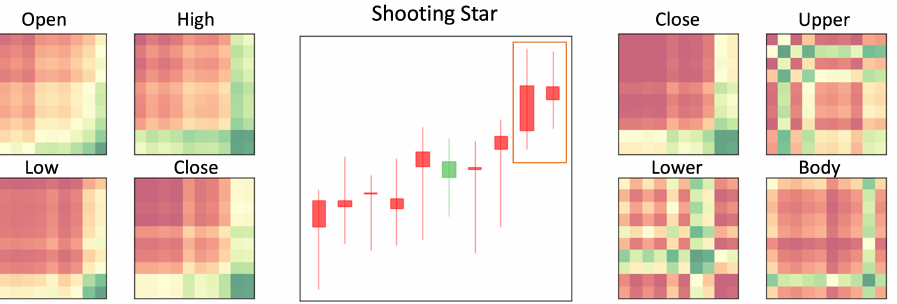
Figure 16. Example of Shooting Star pattern and GASFs. The middlemost figure is the original candlesticks. The red and green candlesticks represent closing prices are higher than the opening prices are not. The left and right sides are the heatmaps of GASFs. The range of the heatmap is ( − 1,1 ) , where red equals − 1 and green equals